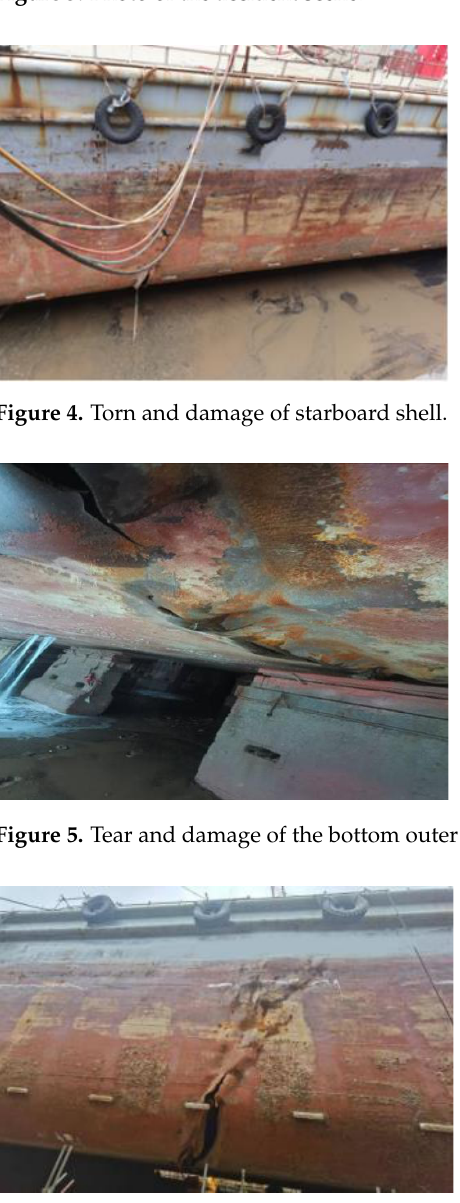
Figure 6. Overall damage to the port skin. Table 2. Hull damage.